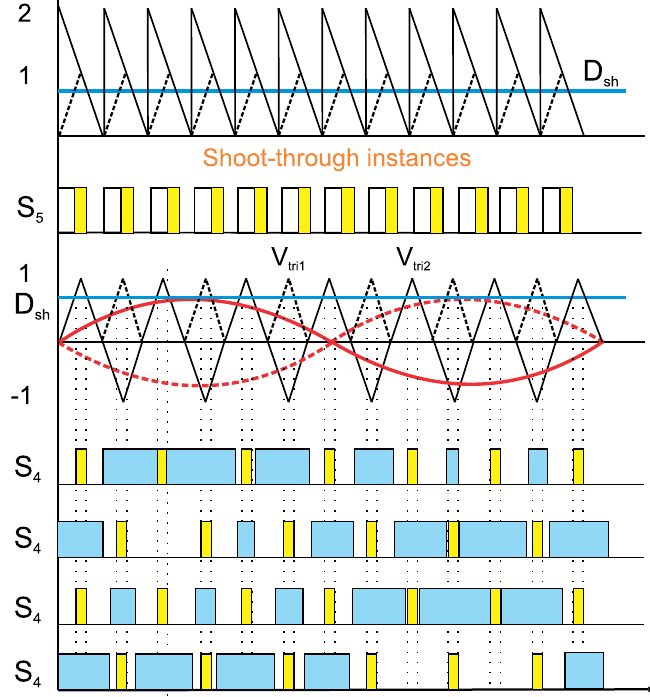
Figure 32. PWM strategy proposed in